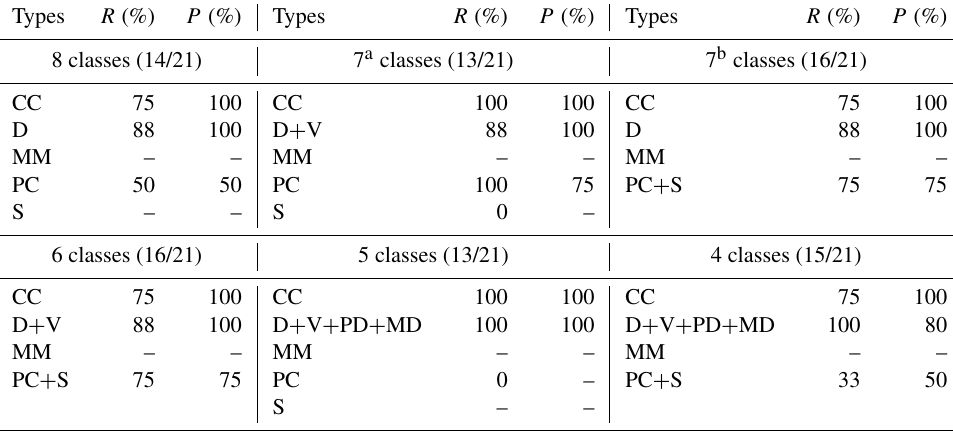
Table 7. Recall ( R ) and precision ( P ) estimated from the classification matrices for 8, 7 a , 7 b , 6, 5, and 4 classes when particle linear depolarization ratio measurements are available. The values between parentheses correspond to the number of layers passed the screening